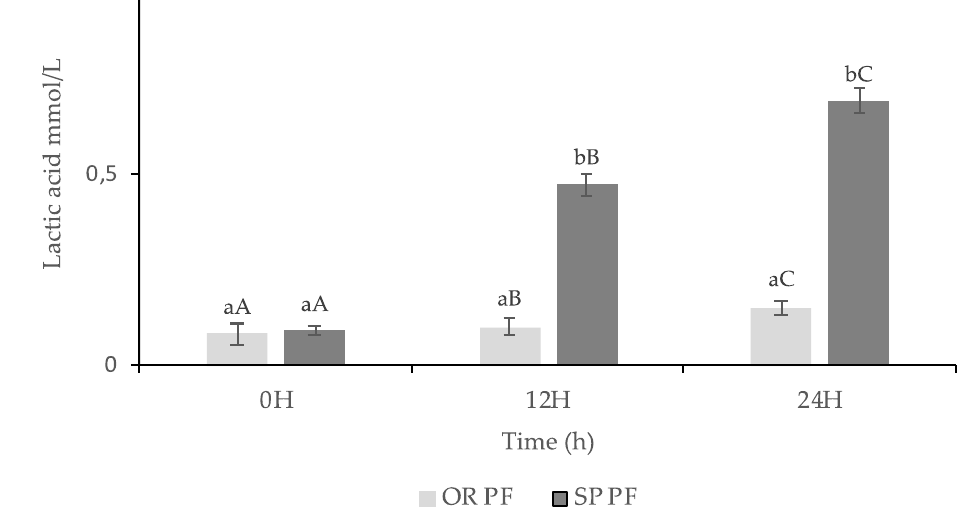
Figure 5. The lactic acid content of final baked goods made with sourdoughs with L. spicheri DSM 15429 (SP PF) and without L. spicheri DSM 15429 (OR PF) at different fermentation times: 0, 12, 24 h, (Values not sharing the same small letters indicate the significant difference between OR PF and SPPF at the same moment: 0, 12, 24H; Values not sharing the same capital letters indicate the significant difference between OR PF and SPPF at different moments: 0, 12, 24H).